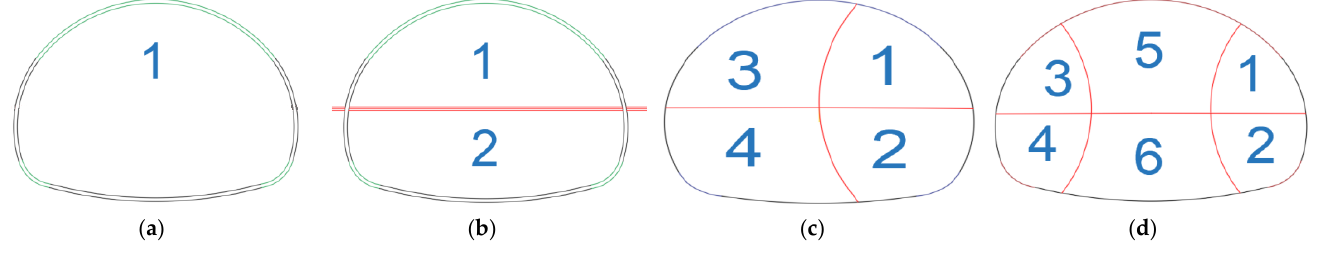
Figure 1. Schematic diagram of the underground interchange hub including the evacuate channel and Luao Road.